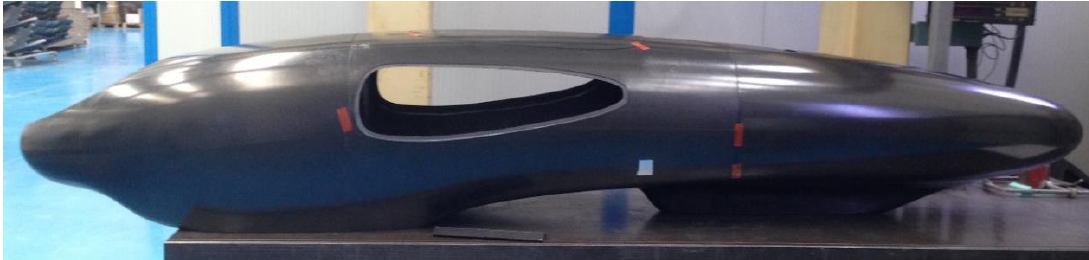
Figure 14. Final central part .